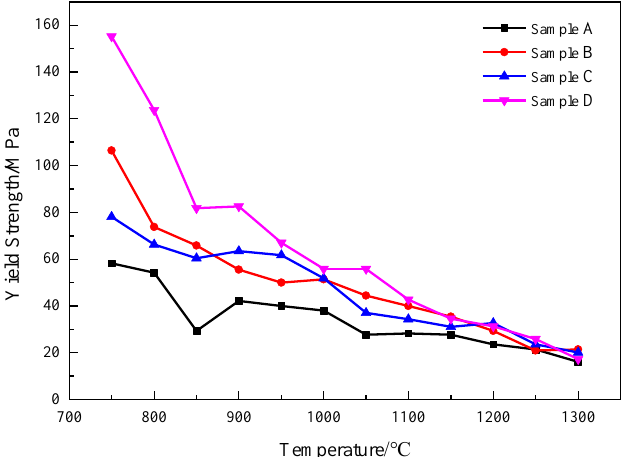
Figure 6. Yield strength curve of high-rise structural steel with different Nb contents.